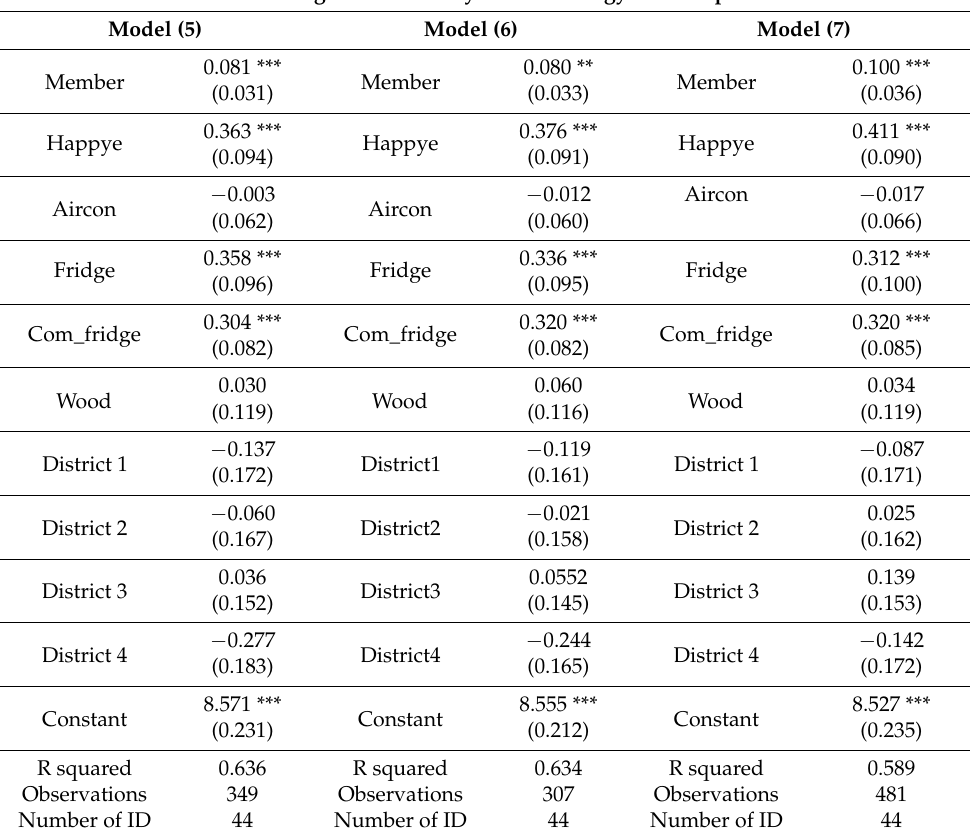
Table A3. Price elasticity of demand regression results.